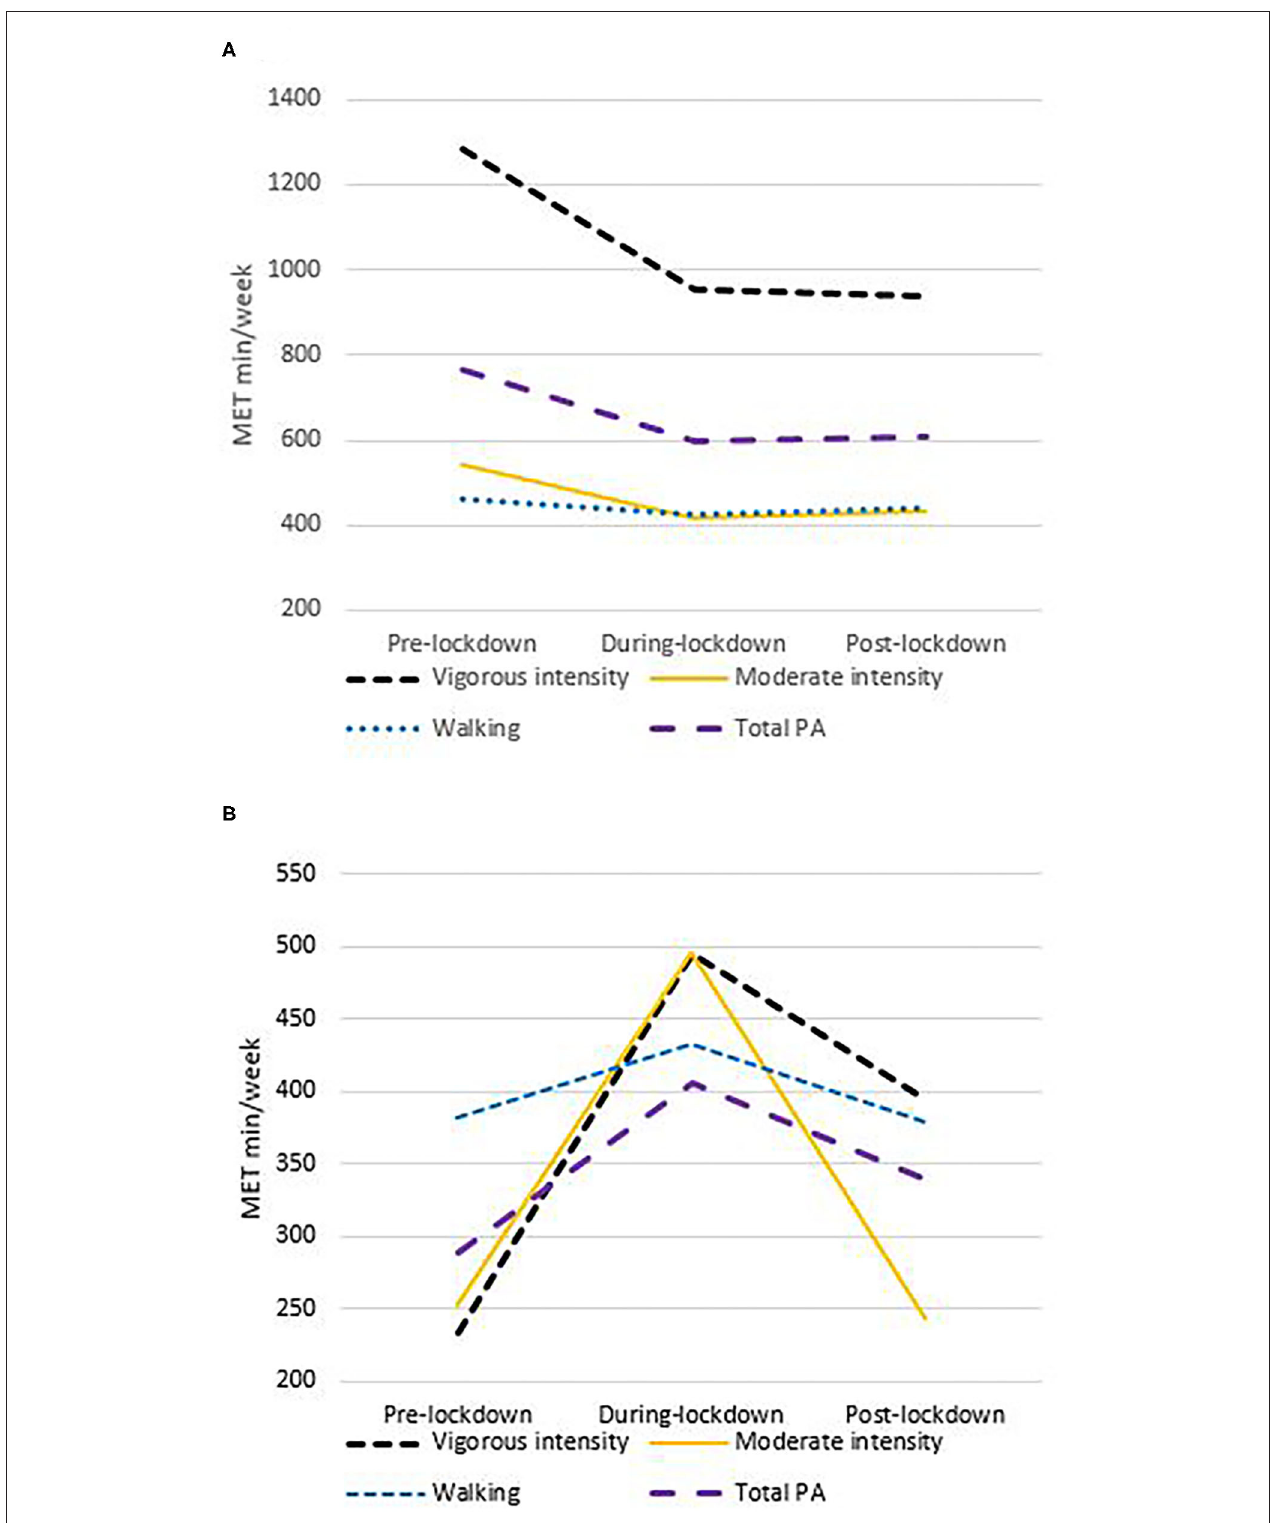
FIGURE 2 | Total PA and vigorous, moderate and walking MET mins/week pre-, during and post-lockdown in highly active (A) and moderately active (B) participants pre-lockdown.